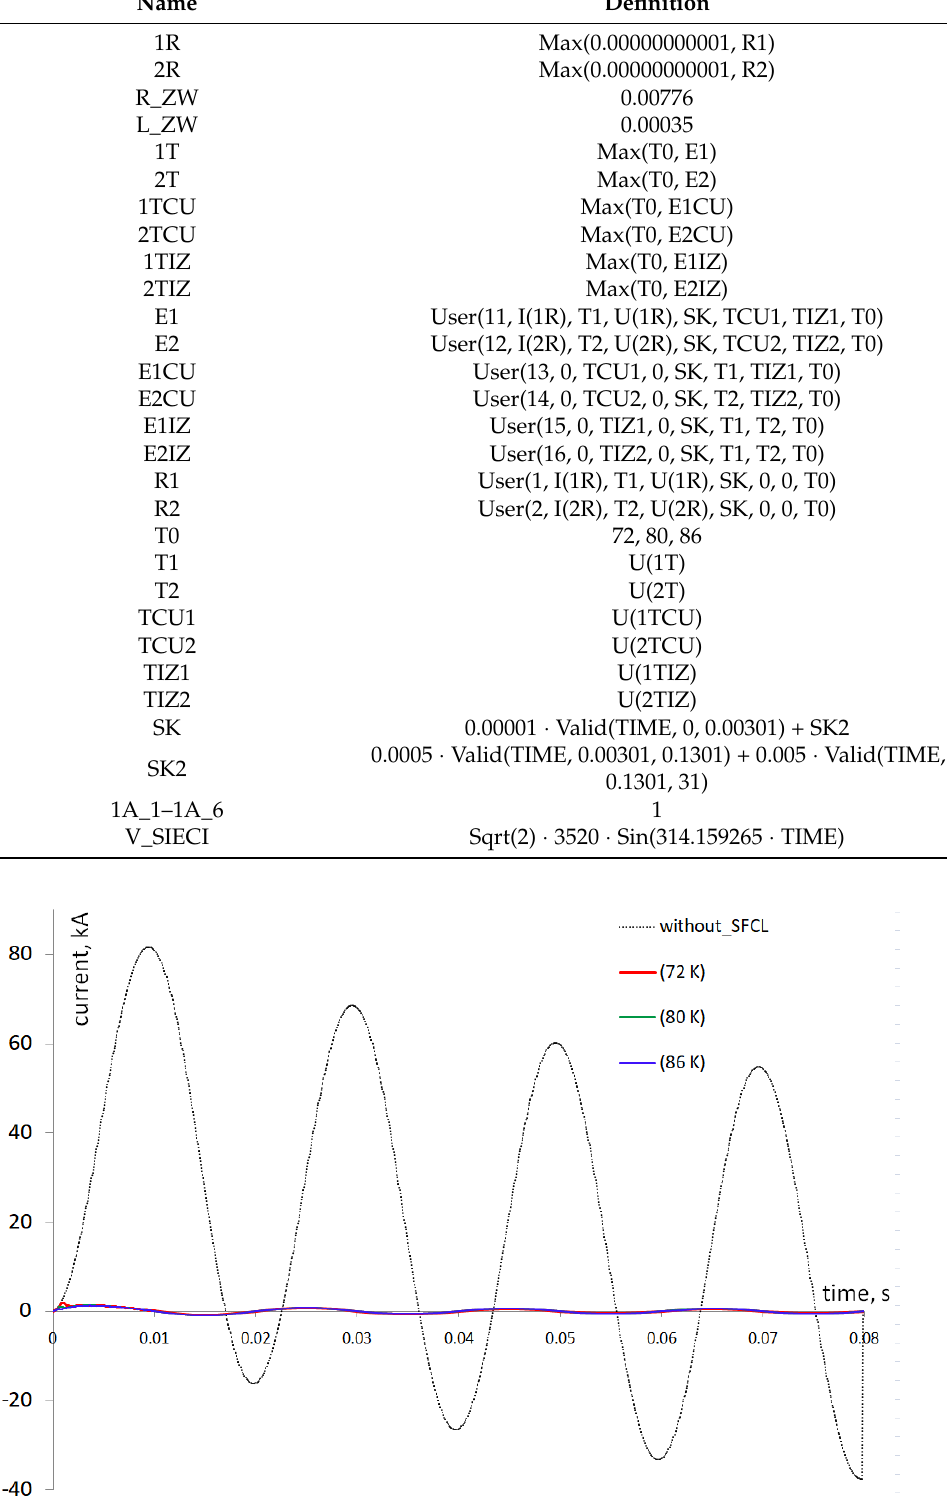
Figure 9. Currents in the short-circuit circuit with a limiter (SFCL) placed in it, cooled to 72 K, 80 K and 86 K, and in the circuit without the limiter (without_SFCL). Time from 0 s to 0.08 s (numerical analysis)